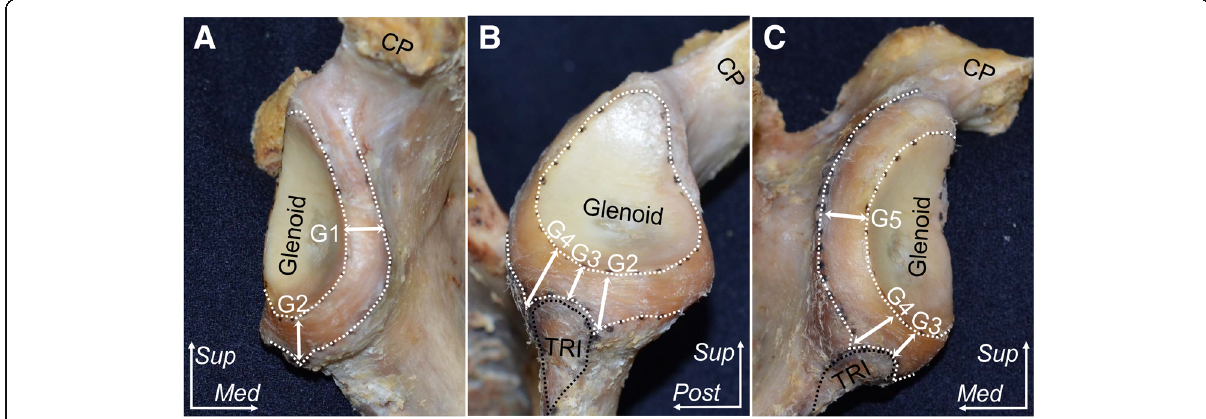
Fig. 4 The glenoidal attachment of articular capsule. The area marked with white dotted lines indicates the attachment area of the articular capsule. a Anterior aspect of the glenoid. b Inferior aspect. c Posterior aspect. Attachment widths were measured at 3 o ’ clock position of the glenoid (G1), the anterior edge (G2), superior part (G3), and posterior edge (G4) of the origin of the long head of triceps brachii, and 9 o ’ clock position of the glenoid (G5). Measurement data are listed in Table 1. CP, coracoid process; TRI, origin of long head of triceps brachii; Med , medial; Post , posterior; Sup ,